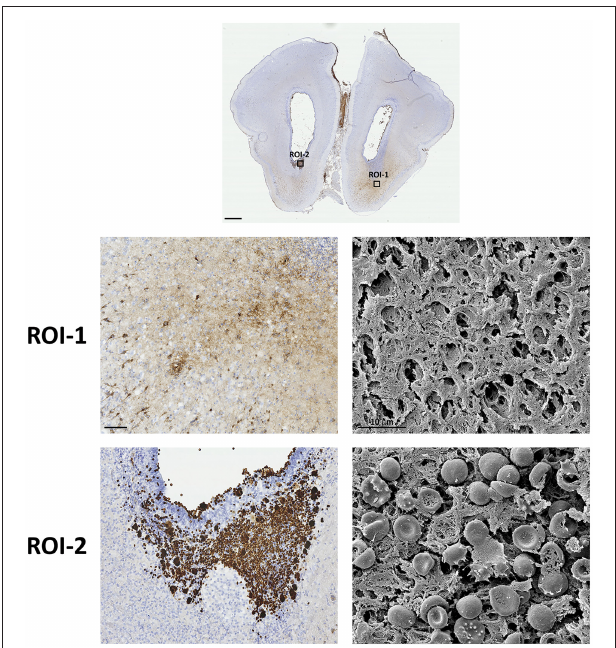
FIGURE 3 | Presence of intracellular and extracellular Hb. The presence of RBCs and Hb following IVH was characterized within the brain utilizing the inherent peroxidase activity of Hb in combination with SEM. Rabbit pups with IVH or sham controls were euthanized at 72h of age followed by saline and freshly prepared 4% PFA perfusion. Afterwards the brains were dissected out from the skulls and immersed in 4% PFA. Brains were prepared and sections at the levels of rostral forebrain (Level 1) were stained for peroxidase activity of Hb or prepared for high magnification SEM as described in the Materials and Methods section. Bright-field microscope analyses were performed on a wide-field Olympus microscope (IX73) and slide scanning were performed on a Hamamatsu NanoZoomer 2.0-HT Digital slide scanner: C10730. Scanning was performed with a 40 × magnification lens. Images used for illustrations, from regions of interest (ROI), were grabbed with the viewer software NDP.view2 Viewing software. Scale bar of slide scan image indicate 1.0mm and of ROI images indicate 100 µ m. SEM specimens were examined in a Philips/FEI XL 30 FESEM scanning electron microscope using an Everhart-Tornley secondary electron detector. Image processing was done with the Scandium software for simple image acquiring and auto-storage into the Scandium database. Scale bar of SEM images indicate 10 µ m.